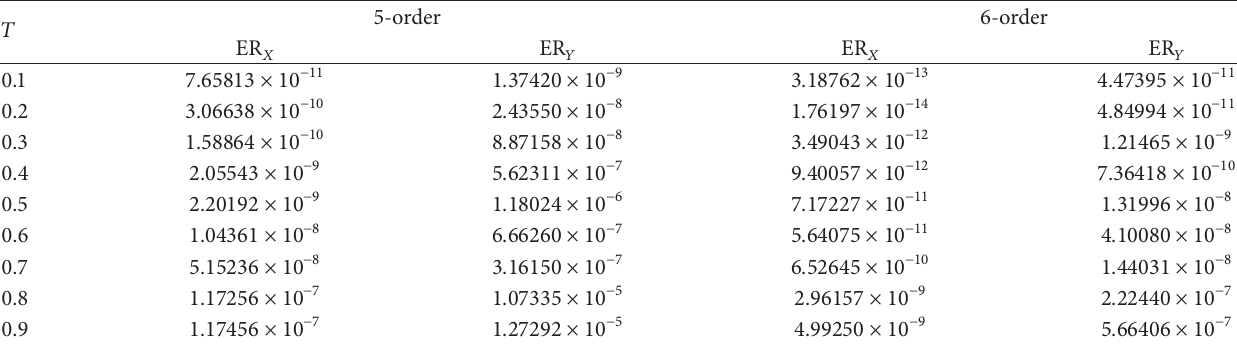
Table 4: The residual errors ER 𝑋 and ER 𝑌 for various 𝑇 ∈ (0, 1) .